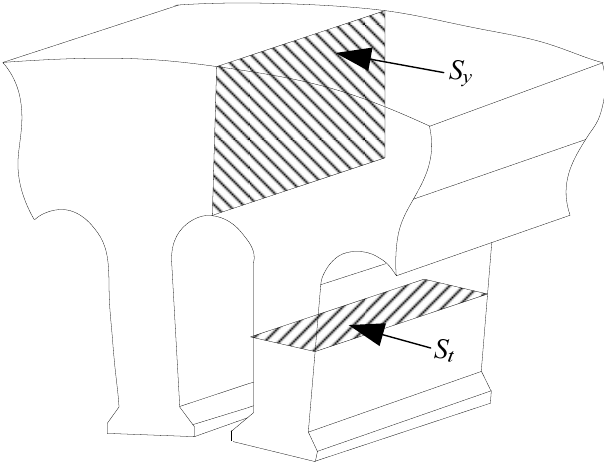
Figure 2. Diagram of stator tooth and stator yoke.